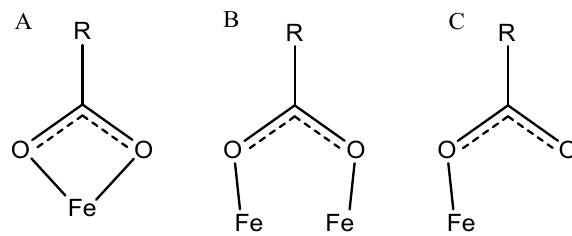
Figure 5. Carboxylate binding models: ( A ) bidentate chelate; ( B ) bidentate bridging; and ( C ) monodentate coordination. Reprinted from [137] with permission from ACS Publications.